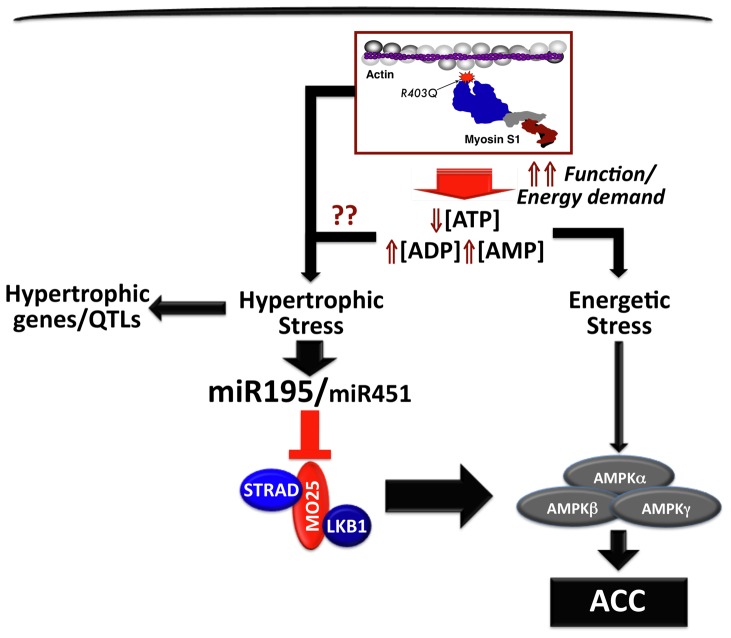
Predicted model of miR-195/mi-R451 regulation of the AMPK signaling axis in R403Q HCM hearts.The functional consequence of the R403Q mutation in the heart is an increase in the relative amount of AMP and ADP. This, in turn, will induce a hypertrophic stress that will elevate expression of miR-195 and miR-451. In addition, the energetic stress caused by this mutation will drive an elevation in AMPK signaling. Based on our findings, the net result is that hypertrophic stress overrides the energetic stress (large arrow) such that miR-195-dependent reduction in MO25 expression leads to a decrease in AMPK signaling indicated by decreased levels of p-ACC.